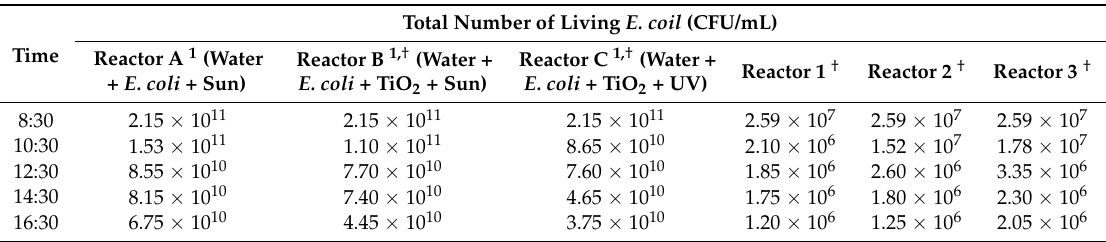
Table 2. Percentage of number of E. coli living cells in the reactors at each operation time interval. of TiO 2 film:water volume in Reactors B and C is 1:2.62. Volume of water in Reactors 1, 2, and 3 is 660, Percentage of Number of Living E. coli (%) Contact Time (h)